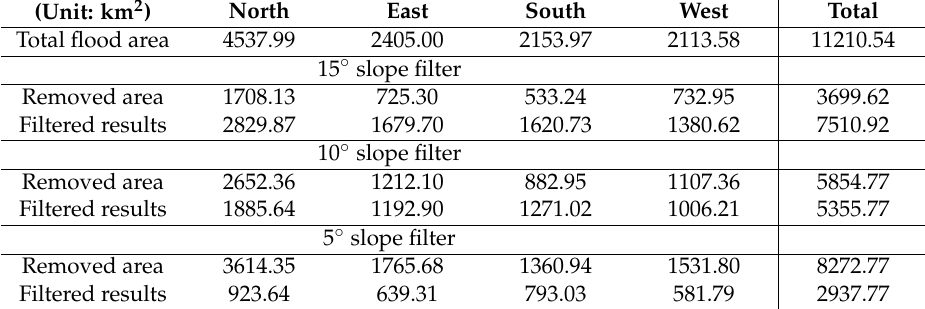
Table 1. The total flooded area, removed area, and filtered results in four